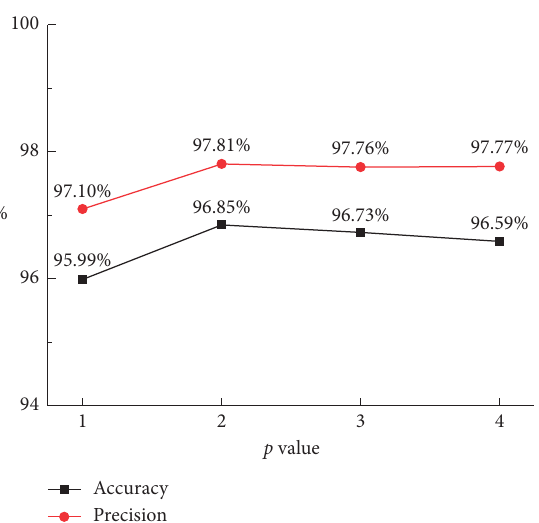
Figure 13: Performance results under different p